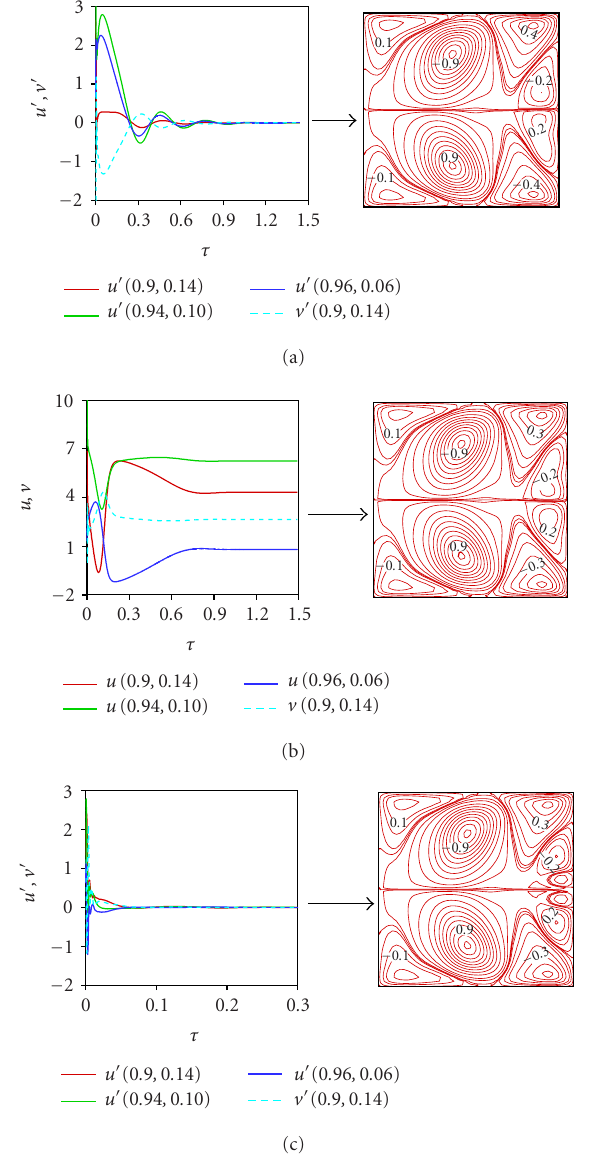
Figure 6: Dynamic responses of the solution at L 2 = − 14 to fi- nite random disturbances: coexistence of three stable steady multi- cell states ( σ = 0 . 02, Pr = 0 . 7, Dk = 300, and L 1 = 28). (a) a labeled in Figure 2b and solution a : u (0 . 9,0 . 14) = 8 . 137; (b) d labeled in Figure 2b and solution d : u (0 . 9,0 . 14) = 2 . 493; and (c) e labeled in Figure 2b and solution e : u (0 . 9,0 . 14) = − 16 . 52. patterns of twelve cells at least. Those for the chaotic oscil-